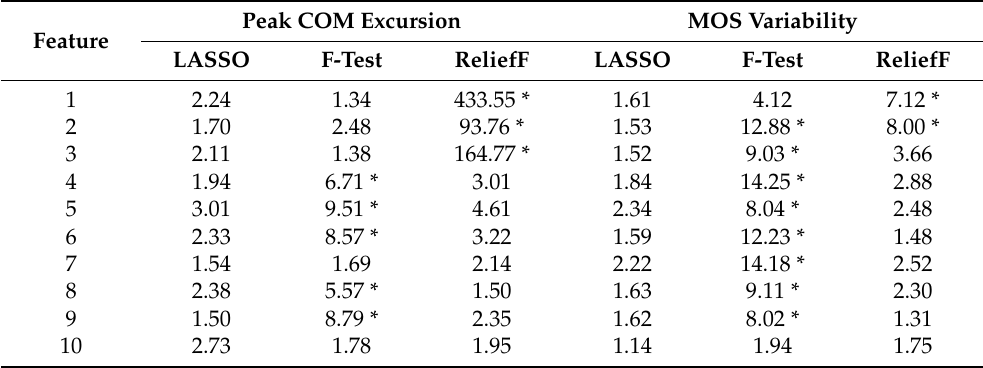
Table 4. VIF values among top 10 features selected by each feature selection method for peak COM excursion and MOS variability (* indicates if VIF >